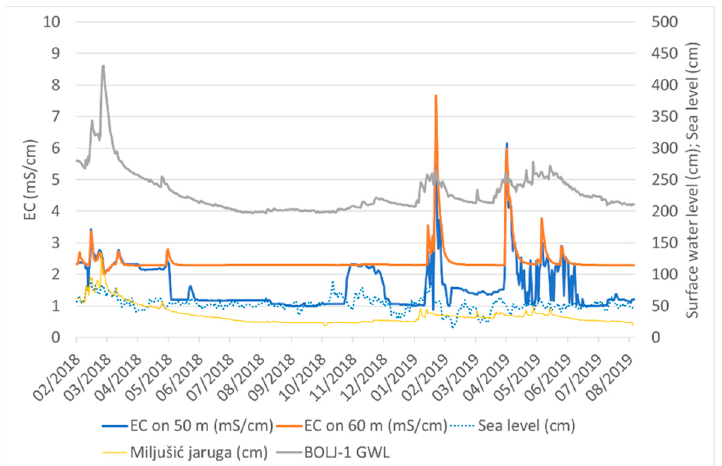
Figure 10. Electrical conductivity on the depth of 60 m (BOLJ-1), Miljaši ć Jaruga flowrate, and sea level.